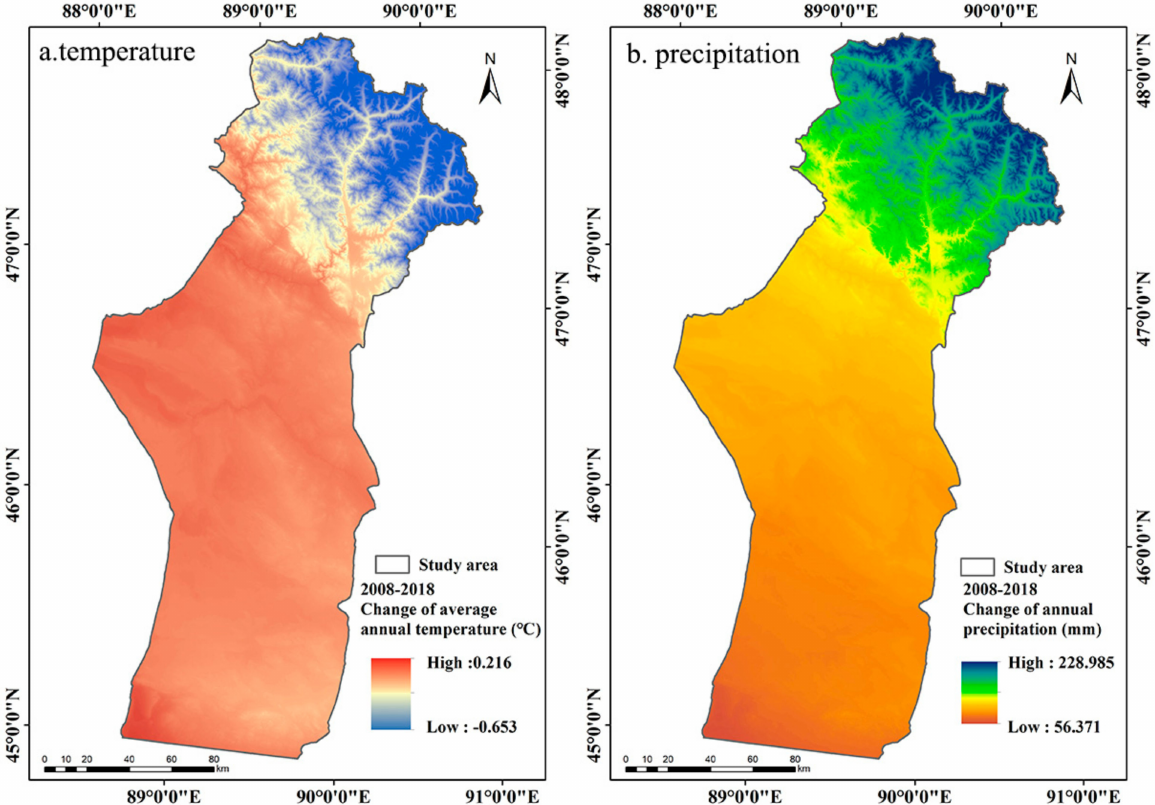
Figure 11. Spatial distribution map of the changes in average temperature and annual precipitation from 2008 to